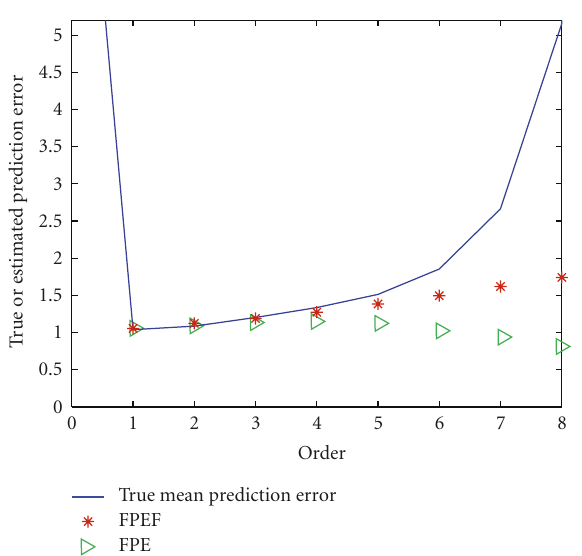
Figure 4: Estimation of prediction error for simulated AR(3) sequence with N =